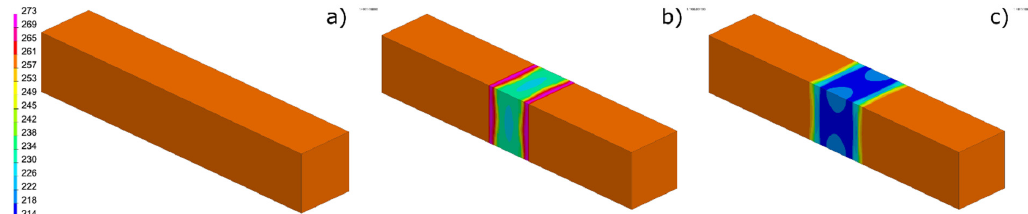
Based on the metallurgical phase distributions and the calculated cooling times t 8 / 5 , VisualWeld (SYSWELD) also allows you to calculate the hardness distribution. The results of selected analyses are presented and compared with the results of real measurements in Figures 12 and 13.